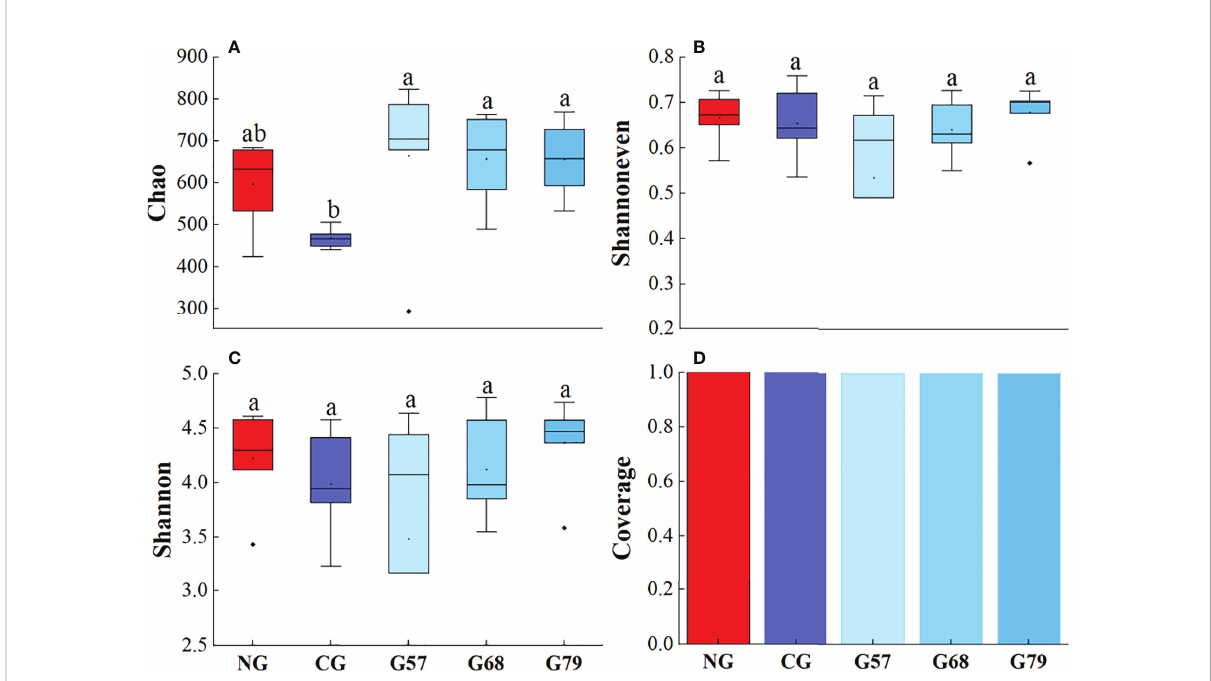
FIGURE 6 Soil fungal diversity in fi ve grassland management treatments: (A) Chao; (B) Shannoneven; (C) Shannon; (D) Coverage. NG: No grazing; CG: Continuous grazing; G57: Grazing in May and July; G68: Grazing in June and August; G79: Grazing in July and September. The error bars in the fi gure represent the standard error, and the lowercase letters represent the signi fi cant differences ( P